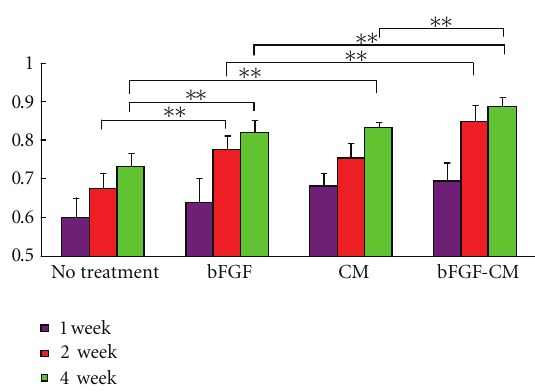
Figure 2: The oxygen saturation parameter ratio of the right, operated hindlimb/the left, nonoperated hindlimb at 1, 2, and 4 weeks ( ∗∗ P < 0 . 01).